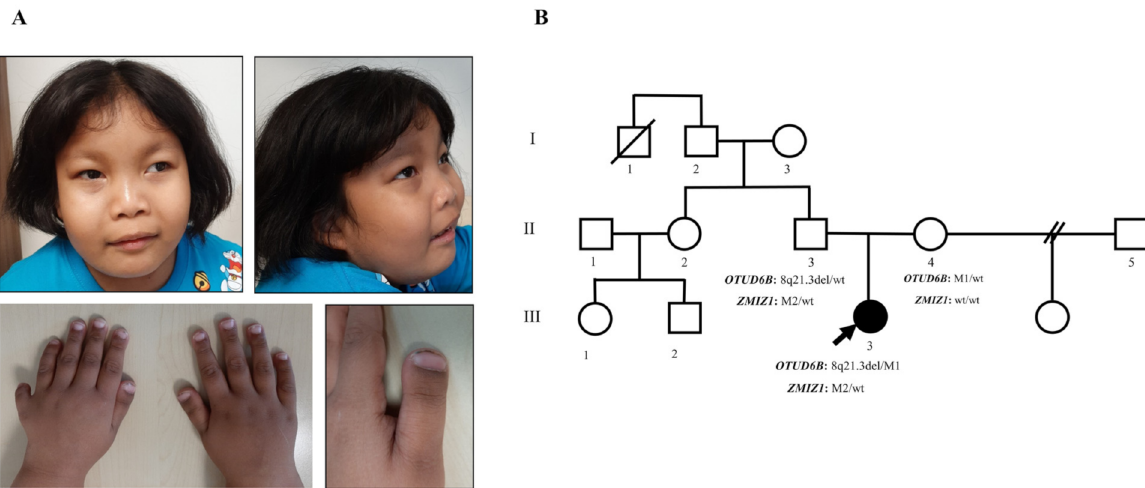
Figure 1. Clinical features and pedigree. ( A ) Photograph of the patient at 5 years of age, showing periorbital edema, arched and sparse lateral eyebrows, prominent nasal bridge, long and smooth philtrum, thin vermillion of the upper lip, hanging lower cheek, postaxial polydactyly of the left hand, terminal broadening of fingers, and broad thumbs. ( B ) Pedigree of the present family. The affected individual is shown by the black-filled symbol. An arrow indicates the proband. The OTUD6B and ZMIZ1 genotype of each individual is indicated below the corresponding symbols. M1: c.873delA; M2: c.1491 + 2T > C; wt: wild